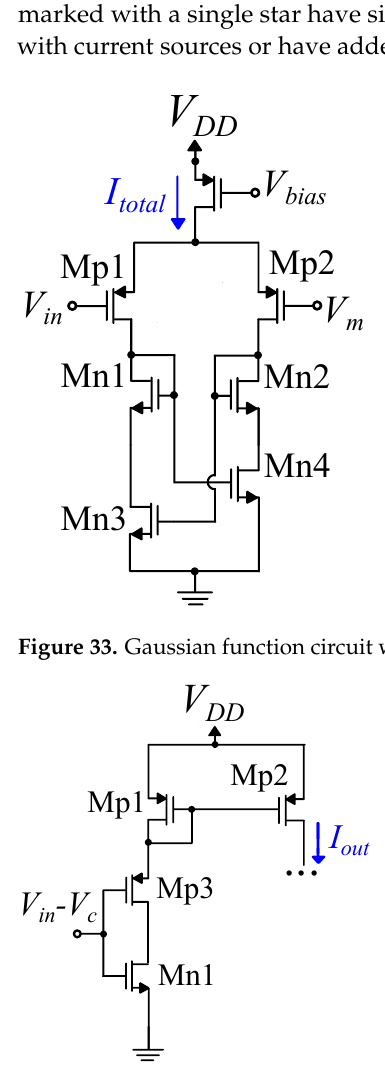
Figure 34. A design inspired by